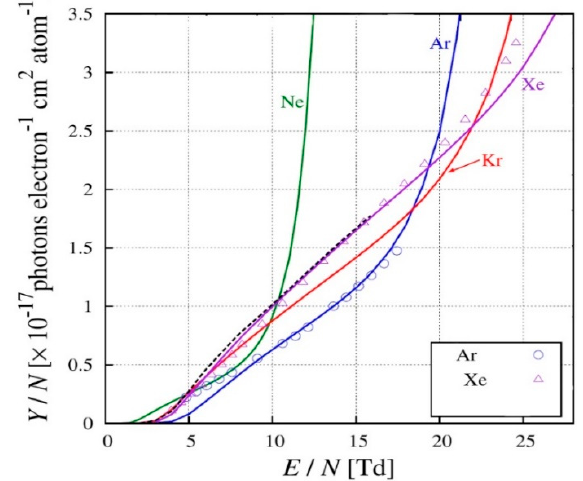
Figure 7. Measured reduced EL yield for ordinary (excimer) EL at room temperature for Ar and Xe (data points), as a function of the reduced electric field, compared to Monte Carlo simulation data (curves), for Ne, Ar, Kr and Xe (from [16], with permission from Elsevier). Far enough from the threshold, the EL yield can be parametrized by a linear function, indicating the proportionality of the EL yield to the electric field: